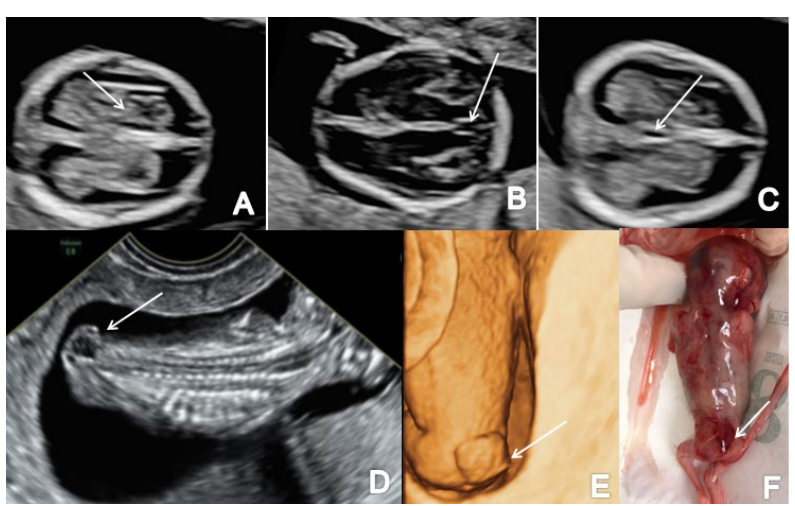
Figure 4. A case of OSB diagnosed at 13 weeks + 2 days (Case 3): ( A ) transverse view of the fetal head showing normal choroid plexus (arrow) and the filling of lateral cerebral ventricles; ( B , C ) further evaluation of the cerebral ventricular system, in transverse planes of the brain showing the aqueduct of Sylvius ( B ) and the third ventricle ( C ) indicated by arrows; ( D ) sagittal view by transvaginal approach demonstrating the defect (arrow); ( E , F ) specimen presentation after medical TOP.